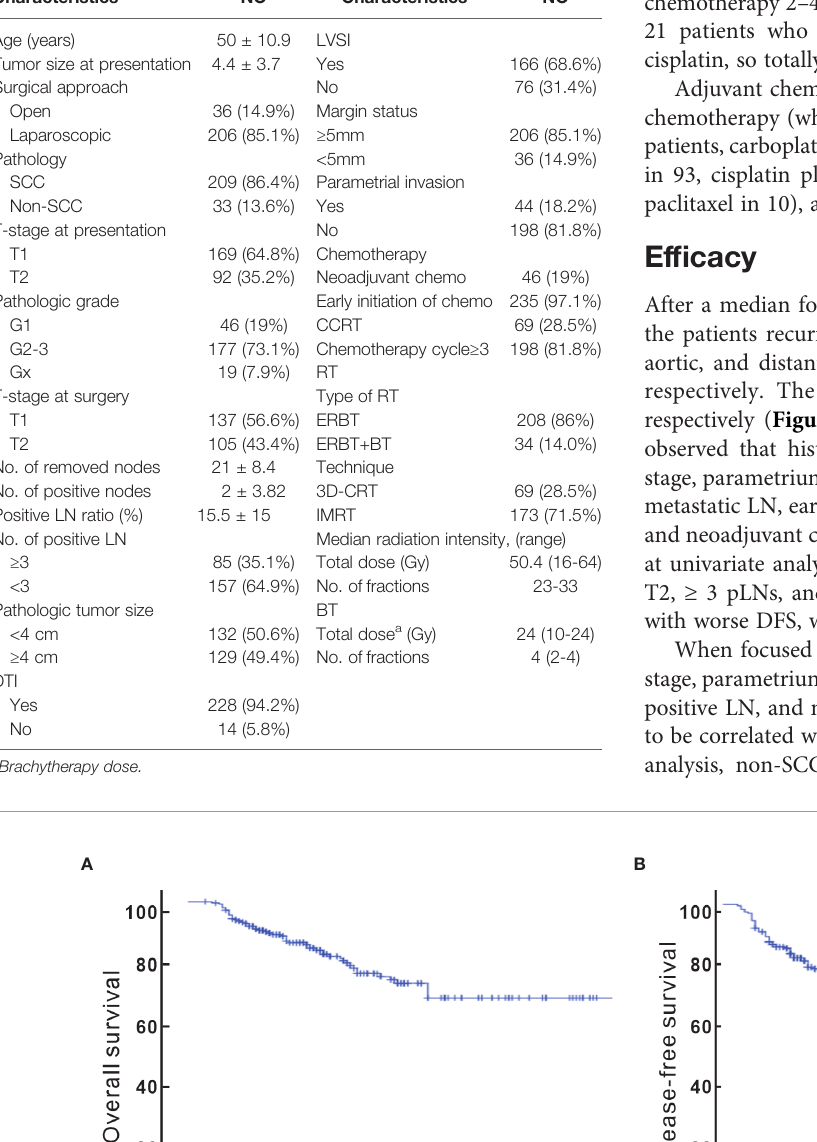
TABLE 1 | Patient and treatment characteristics. Characteristics